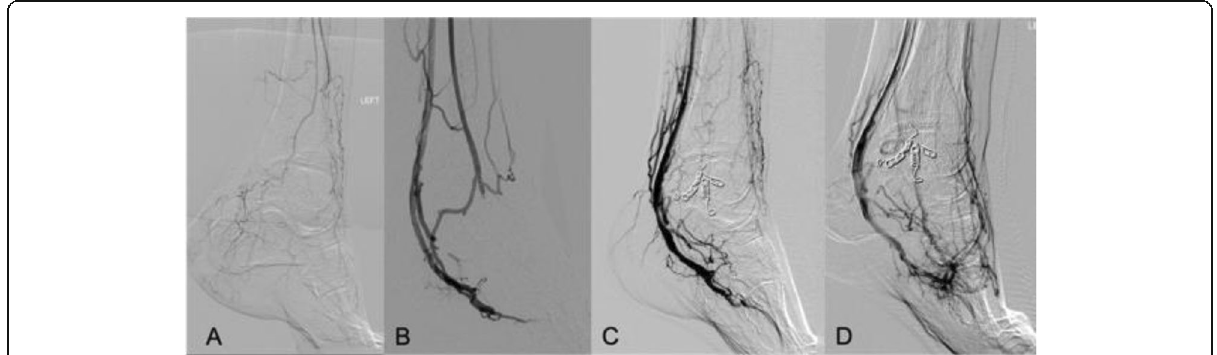
Fig. 1 A Baseline angiogram, 1 month prior to pDVA B ) post index pDVA, C ) post collateral vein embolization D ) post final outflow optimisation with angioplasty of the pedal venous